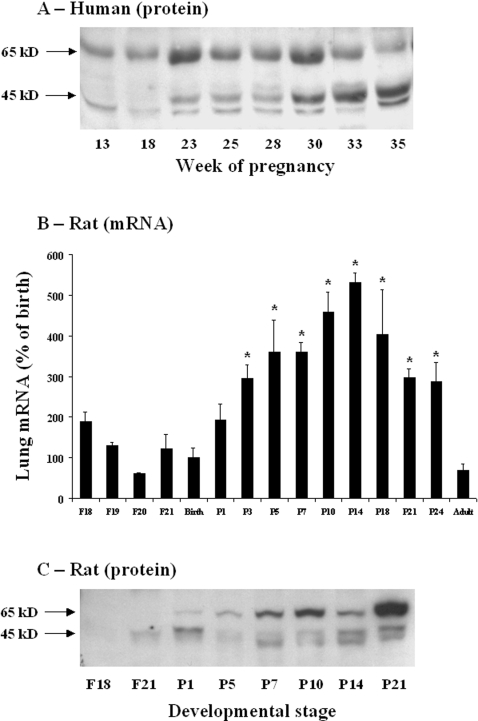
Developmental pattern of MMP16 gene and protein expression in control lungs.A. Immunoblot of lung homogenates from human fetuses without lung disease, at 11 to 36 weeks of gestation. B. Changes in the MMP16 mRNA expression level in rat whole lung tissue. Expression was quantified by real-time PCR from fetal life (canalicular stage of development) to adulthood, in 3 to 5 individual lung samples per stage. The birth level was arbitrarily given a value of 100. Values are means±SEM. * p<0.05 versus birth level. C. Immunoblot of lung homogenates from control rats, from fetal life to adulthood.